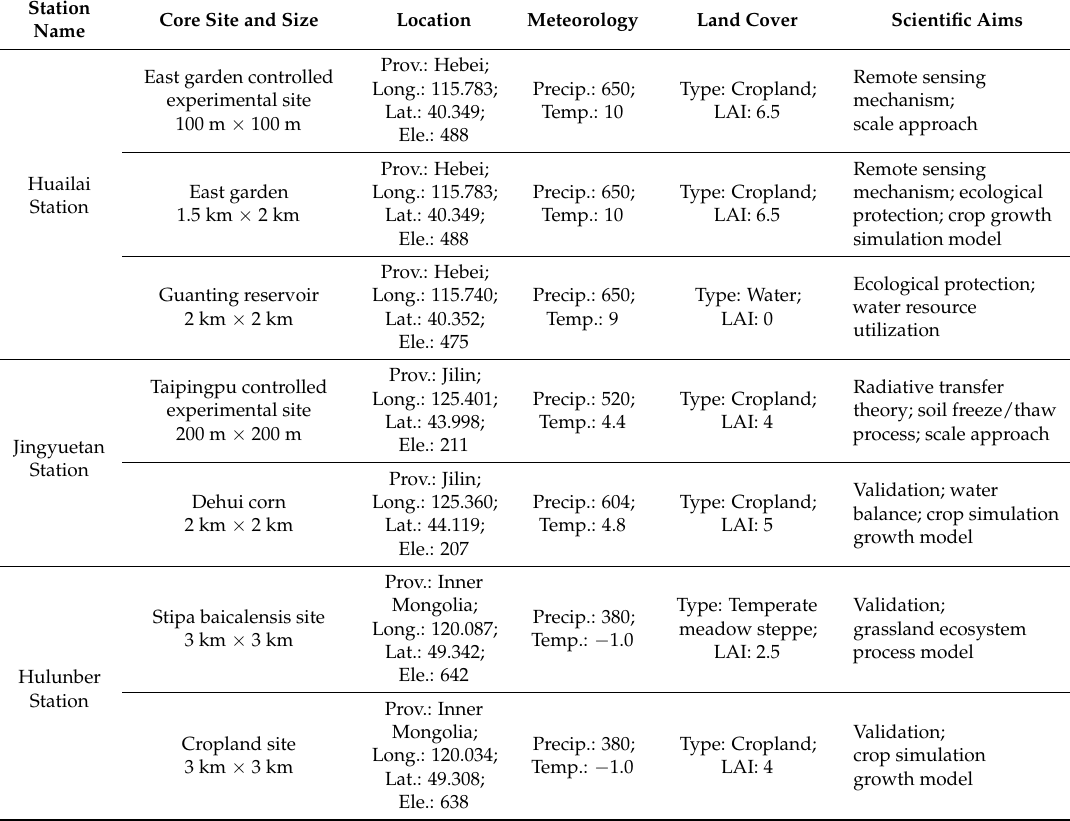
Table 2. Summary information of core observation stations in the validation network